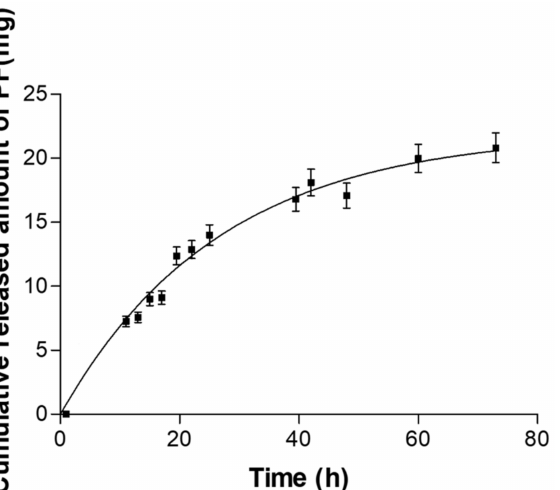
Figure 7. In vitro release profiles of PF from hydrogel. The data were obtained from the mean of three experiments, ( n = 3) ± standard deviation